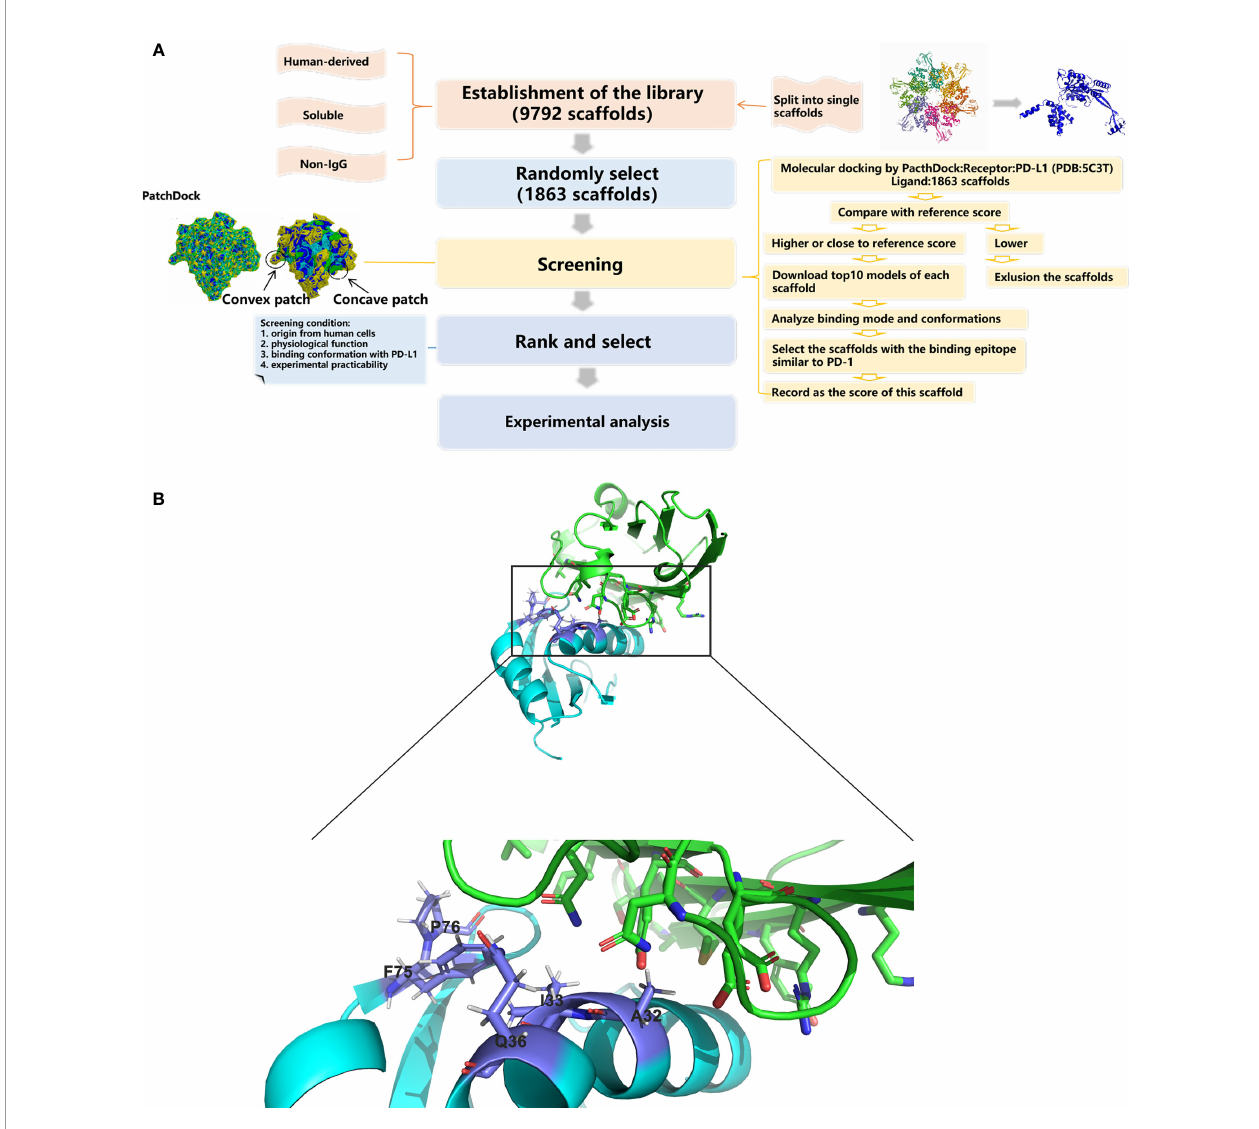
FIGURE 1 | Schematic drawings of the screening processes and interactions of U1 snRNPA/PD-L1. (A) Flow chart of database construction and screening processes. (B) Cartoon representations for the identi fi ed interface of U1 snRNPA/PD-L1 complex. Cyan, U1 snRNPA (PDB: 1U6B); green, PD-L1. Stick representations show the key